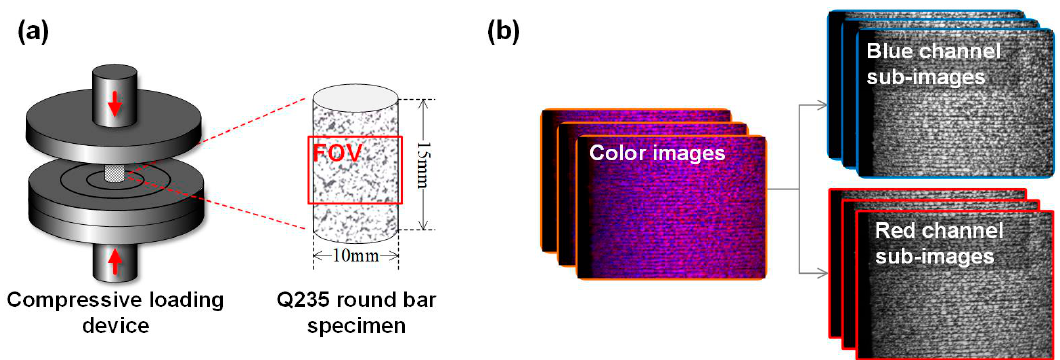
Figure 11. ( a ) schematic of the compressive loading device and ( b ) captured images and separated blue and red channel sub-images.